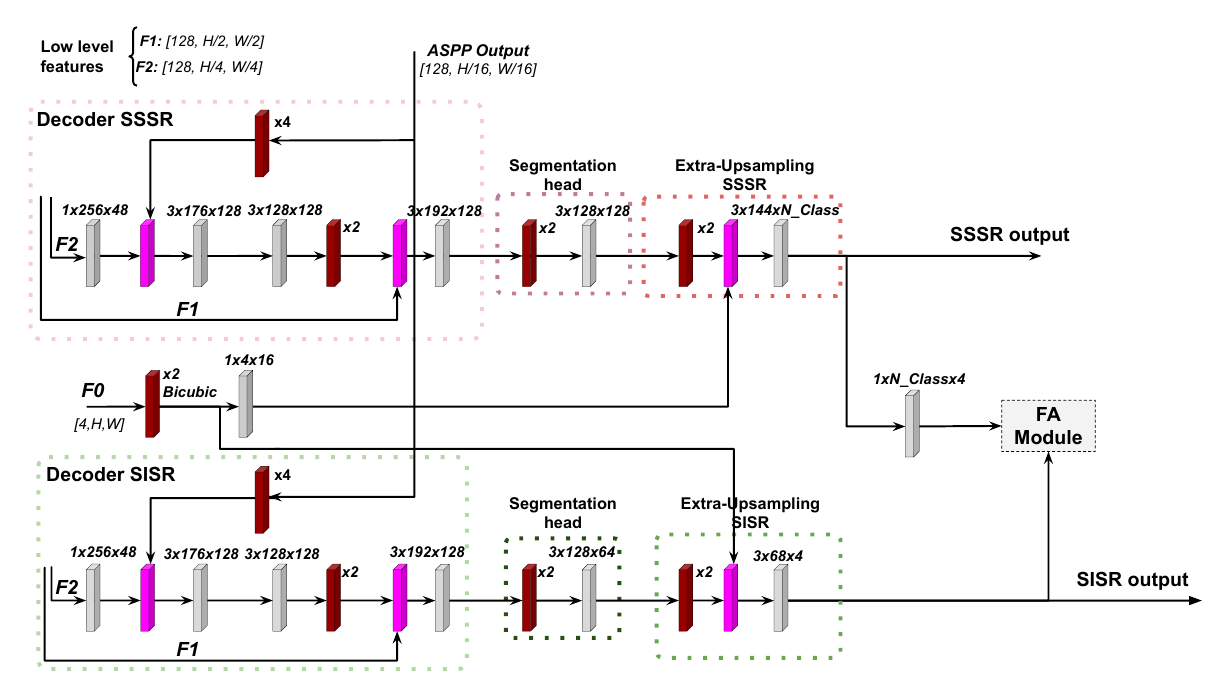
Figure 6. Implementation details of both decoders. Each convolutional layer is characterized by [kernel-size × input- channels ×